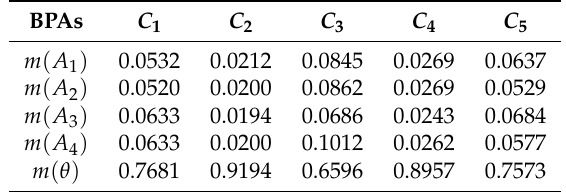
Table 11. The BPAs of the propositions with respect to different criteria.